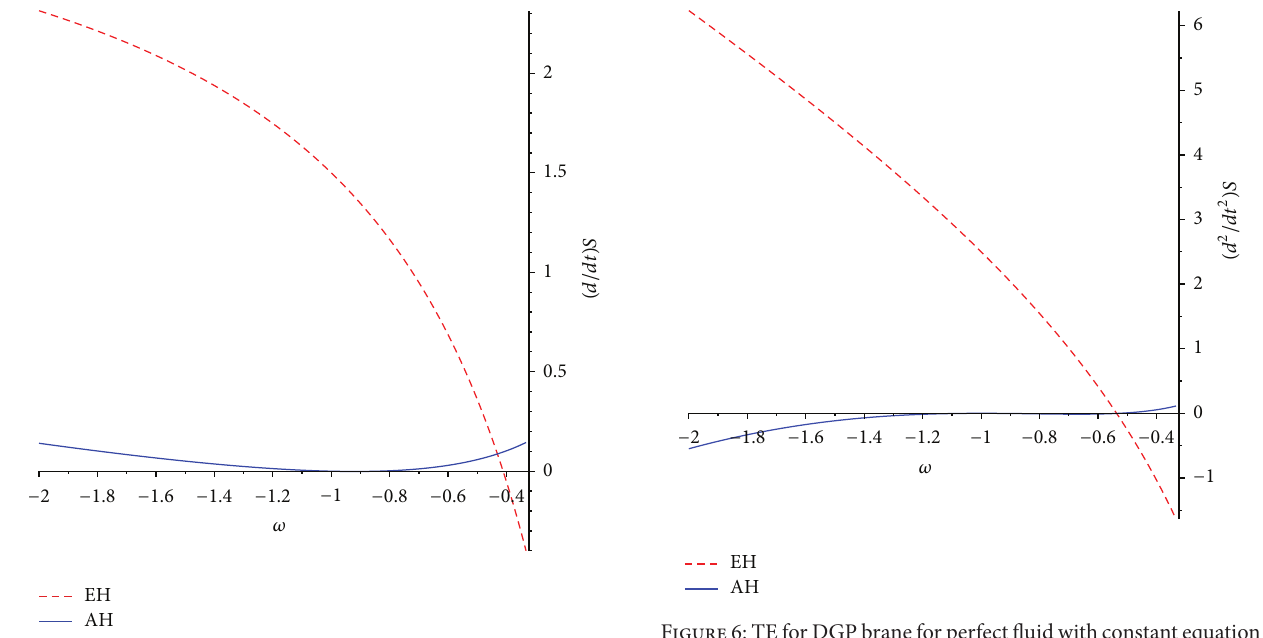
Figure 5: GSLT for DGP brane for perfect fluid with constant equa- tion of state.